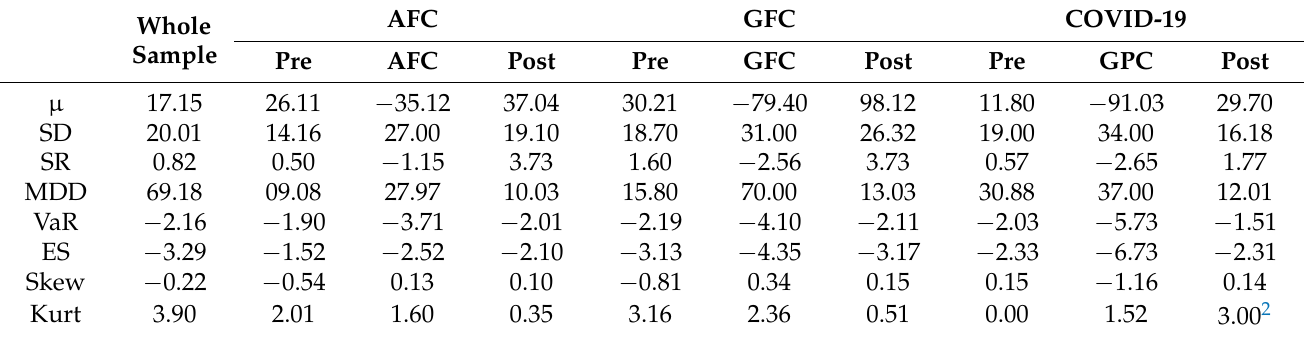
Table 1. Effect of Market Turmoil on Financial Performance of PSX-100 Index.